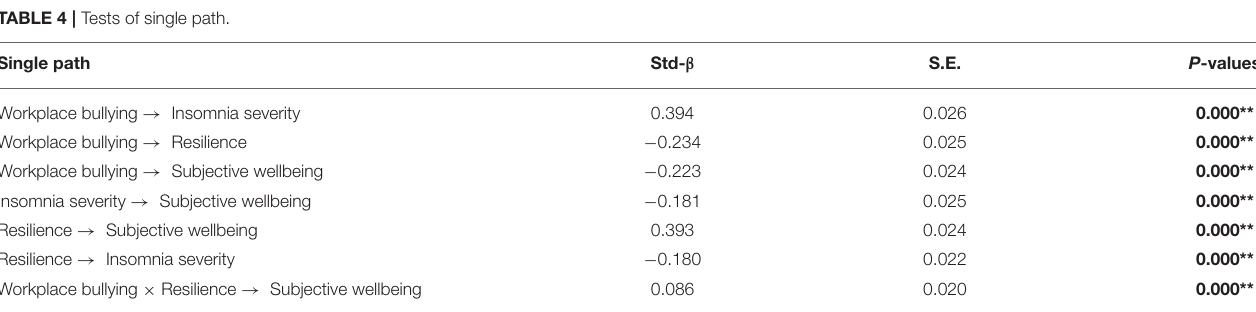
TABLE 4 | Tests of single